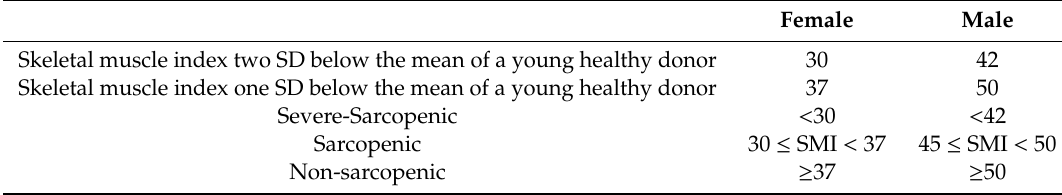
SD: standard deviation; SMI: skeletal muscle